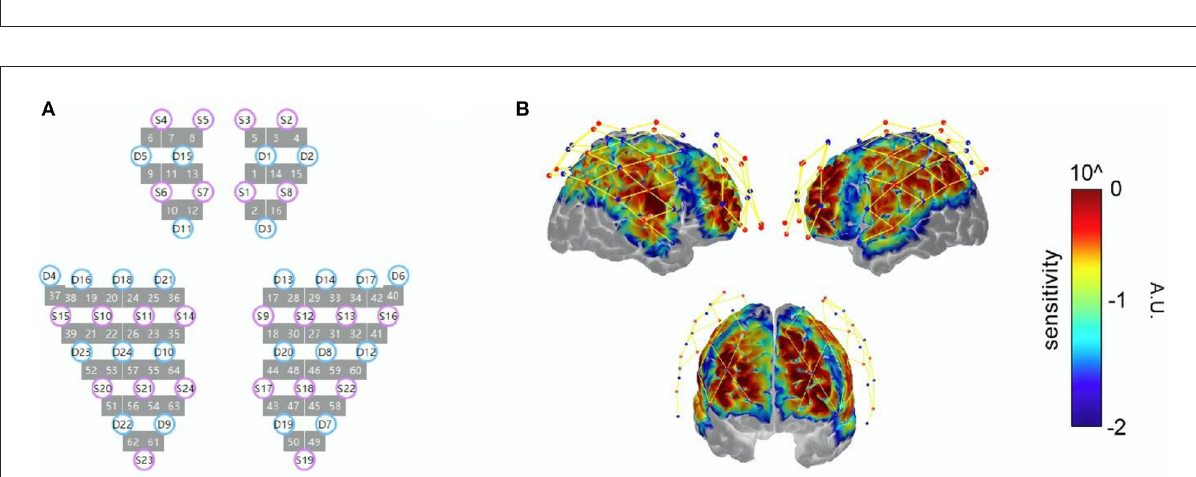
FIGURE1 fNIRS behavioral tasks. (A) Picture-naming task. (B) Phrase repetition task.